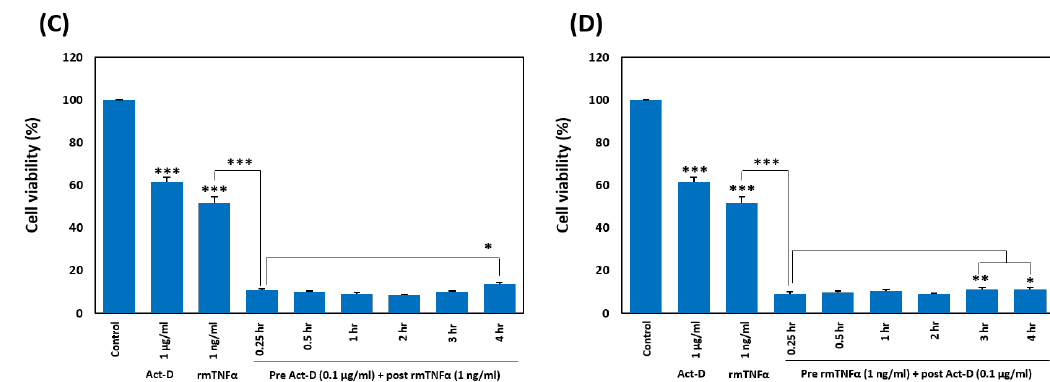
Figure 5. Timing-dependent attenuation of sensitization by act-D. ( A , C ) Both HDFs ( A ) and L929 cells ( C ) were pretreated with act-D, followed by treatment with respective TNF-α at the indicated time points. After 24 h, cell viability was measured by the MTT assay. ( B , D ) Both HDFs ( B ) and L929 cells ( D ) were pretreated with respective TNF-α, followed by treatment with act-D at the indicated time points. After 24 h, cell viability was measured by the MTT assay. All experiments were independently conducted four times and means ± SEM of the independent experiments were subjected to a two-tailed paired Student’s t -test (* p < 0.05, ** p < 0.01, *** p < 0.001).